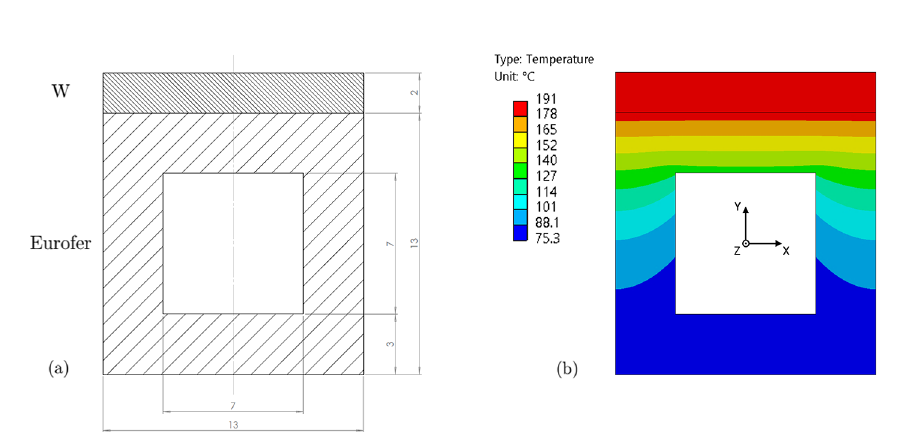
Fig. 2. – (a) 2D geometry of the model. (b) Temperature contours in the solid domains.